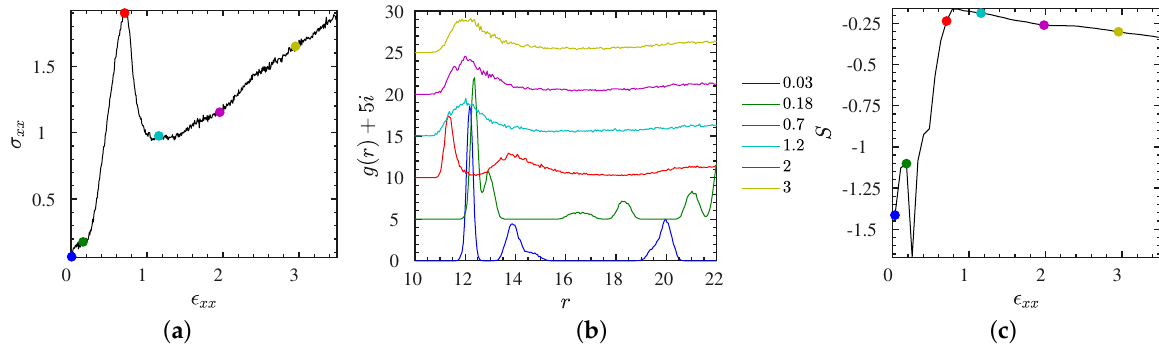
Figure 5. System L2 • subjected to strain rate ˙ (cid:101) xx = 0.005 at different stretching strains. ( a ) stress–strain curve. ( b ) NP–NP pair correlation function at the strains marked by colorful bullets in ( a ). The curves are shifted upward by their index i = 0,...,5 where, e.g., i = 0 for the blue line (0.03 strain) and i = 5 for the yellow line (3 strain). ( c ) Corresponding information measure S obtained from g ( r ) shown in ( b ) via Equation (5). Snapshots for the marked states are provided in Figure 6.